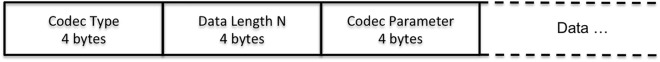
Data structure of custom encoded record in MMTF.A Codec Type describes the columnar encoding strategy. A Codec may describe the combination of several encoding strategies. For example, coordinate data are encoded by a Codec that combines integer encoding, delta encoding, recursive index encoding. Data Length represents the number of values that have been encoded, and here the Codec Parameter for coordinate encoding is a divisor to convert integers to floating point numbers.